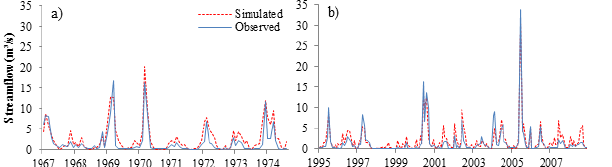
Table 2. Land use changes in the Tapacurá River basin.